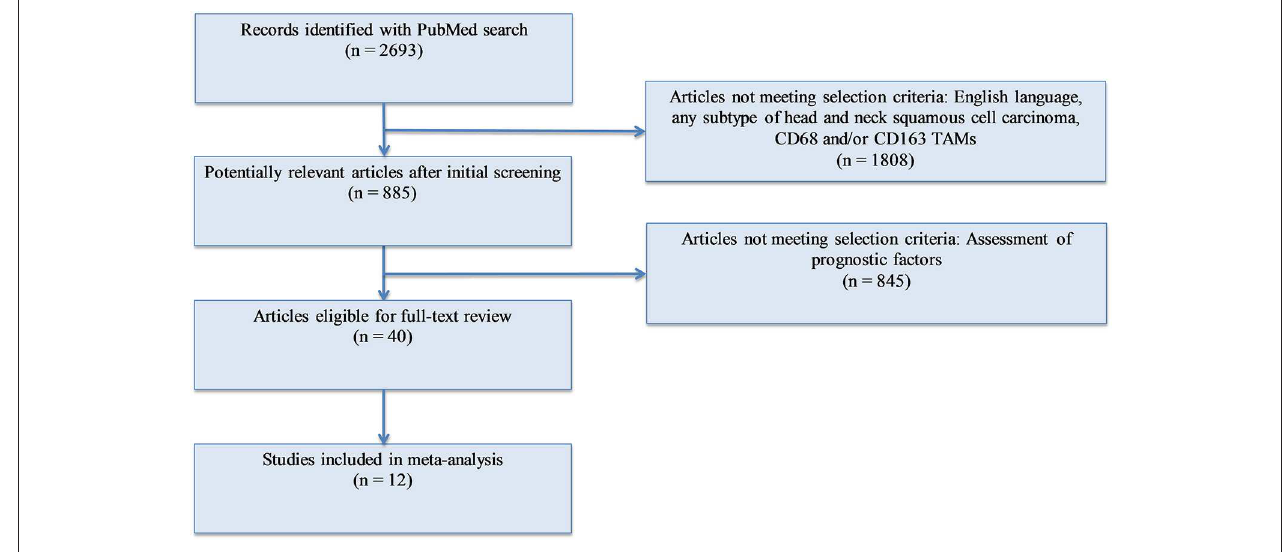
FIGURE 1 | Flowchart of systematic review.